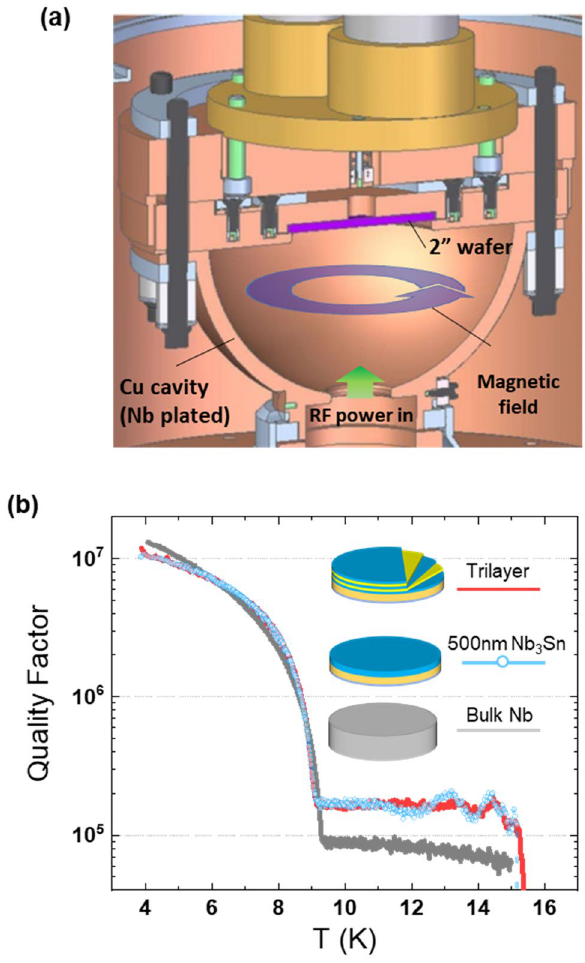
Figure 6. ( a ) Cutaway of hemispherical resonator cavity at SLAC used for these measurements. RF power is pumped in at the bottom, and magnetic field lines oscillate parallel to sample surface. ( b ) RF Surface resistance measurements of Nb 3 Sn film and multilayer compared to cavity-grade